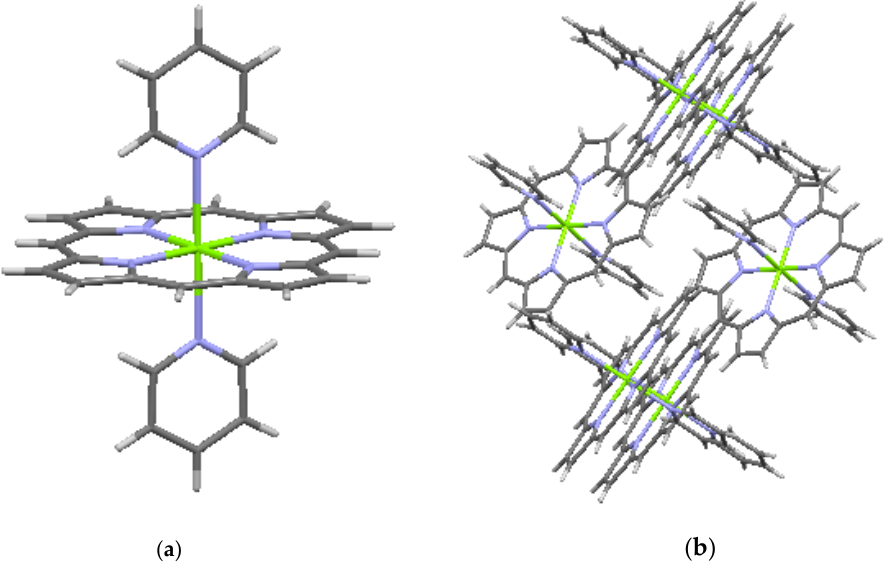
Figure 6. Mg-porphine, from data of [7,17]: ( a ) single molecule; and ( b ) crystal packing. Light green = Mg.